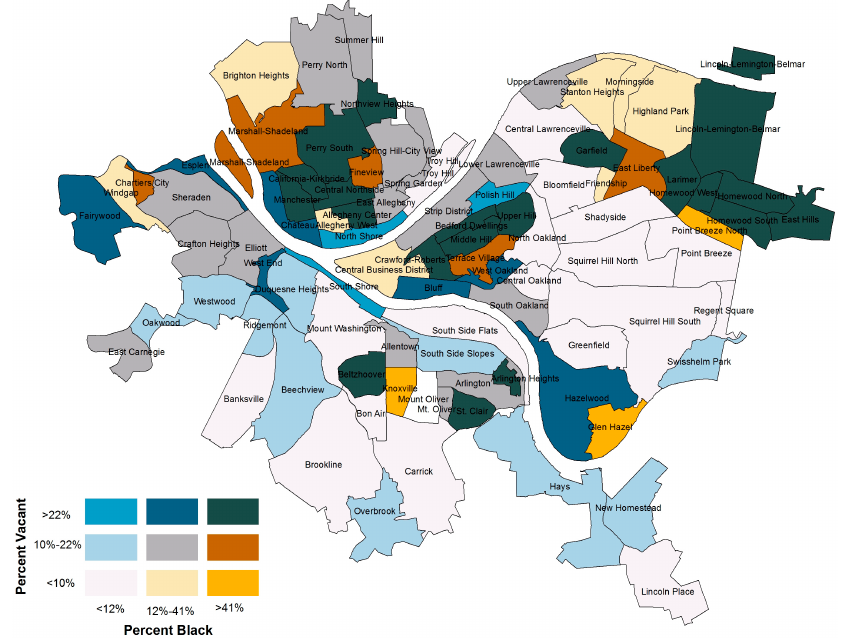
Figure 3. Map of vacancy by percent black across Pittsburgh Figure 3 . Map of vacancy by percent black across Pittsburgh neighborhoods.